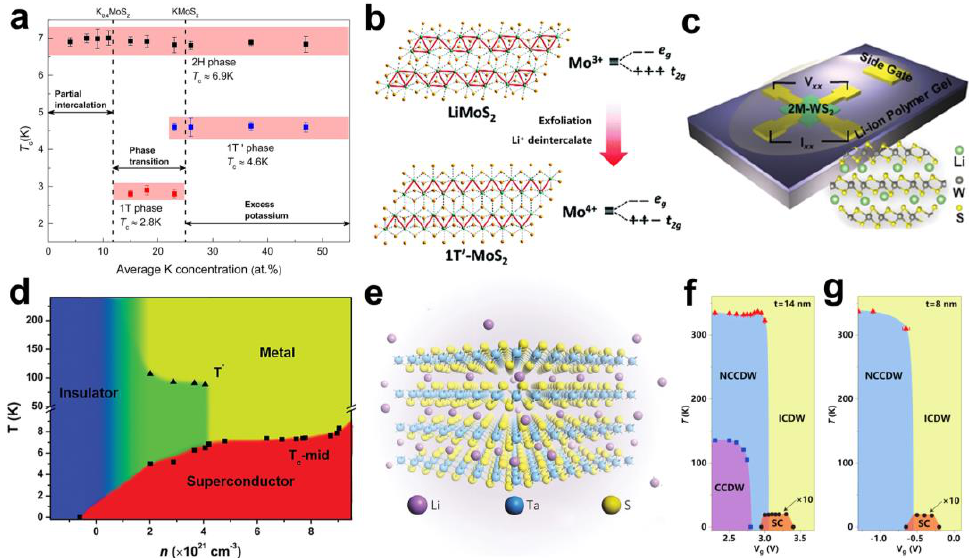
Figure 3. ( a ) K x MoS 2 superconducting structural phase that varies with K content. Reproduced with permission from Ref. [32]. Copyright 2016, American Chemical Society. ( b ) Schematic diagram of the formation of Mo-Mo zig-zag chains in 1 T′ -MoS 2 . Reproduced with permission from Ref. [34]. Copyright 2017, Royal Society of Chemistry (London, UK). ( c ) Schematic diagram of the 2M-WS 2 - based gated lithium ions intercalation device. Reproduced with permission from Ref. [37]. Copyright 2019, Wiley − VCH. ( d ) Carrier density − temperature phase diagram of 2M-WS 2 with lithium ion intercalation. The transition temperature T* is an unknown phase transition. Reproduced with permission from Ref. [37]. Copyright 2019, Wiley − VCH. ( e ) Schematic diagram of the lithium ion intercalation structure of 1T-TaS 2 . Reproduced with permission from Reference [40]. Copyright 2015, Springer Nature (Berlin, German). ( f , g ) Temperature − gated voltage phase diagrams of 1T-TaS 2 at 14 nm ( f ) and 8 nm ( g ). Reproduced with permission from Ref. [40]. Copyright 2015, Springer Nature.